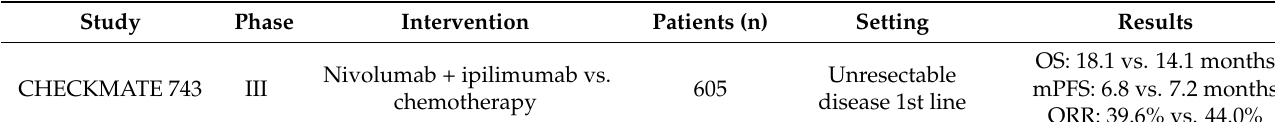
Table 2. Completed randomized trials of immunotherapy in